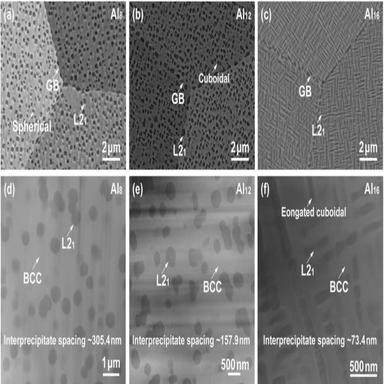
Backscattered electron (BSE) images and bright field (BF) images of Fe71.5-x(Ni, Cr, Ti)28.5Alx CCAs: (a, d) Al8 CCA, (b, e) Al12 CCA, and (c, f) Al16 CCA.